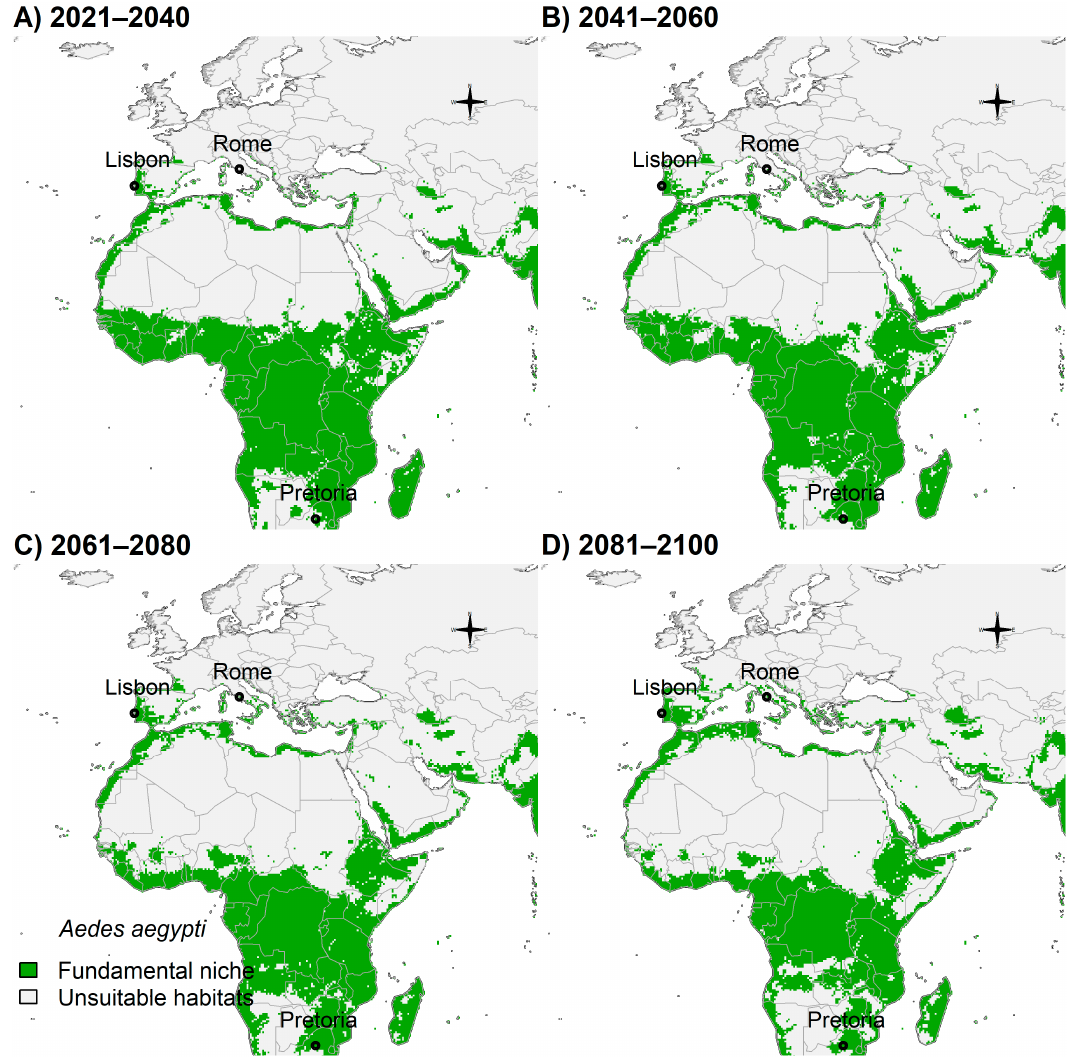
Figure 4. Potential future distribution of Ae . aegypti in Europe and Africa: ( A ) 2021–2040; ( B ) 2041–2060; ( C ) 2061–2080; and ( D ) 2081–2100. Future climate projections based on the global climate model GFDL-ESM4.1 by NOAA in the shared socio-economic pathway SSP3-7.0 of region rivalry. Locations of capitals of countries were shown for reference.